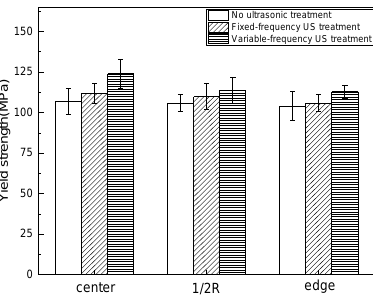
Figure 10. Yield strength of ZK60 alloy with different ultrasonic treatments.